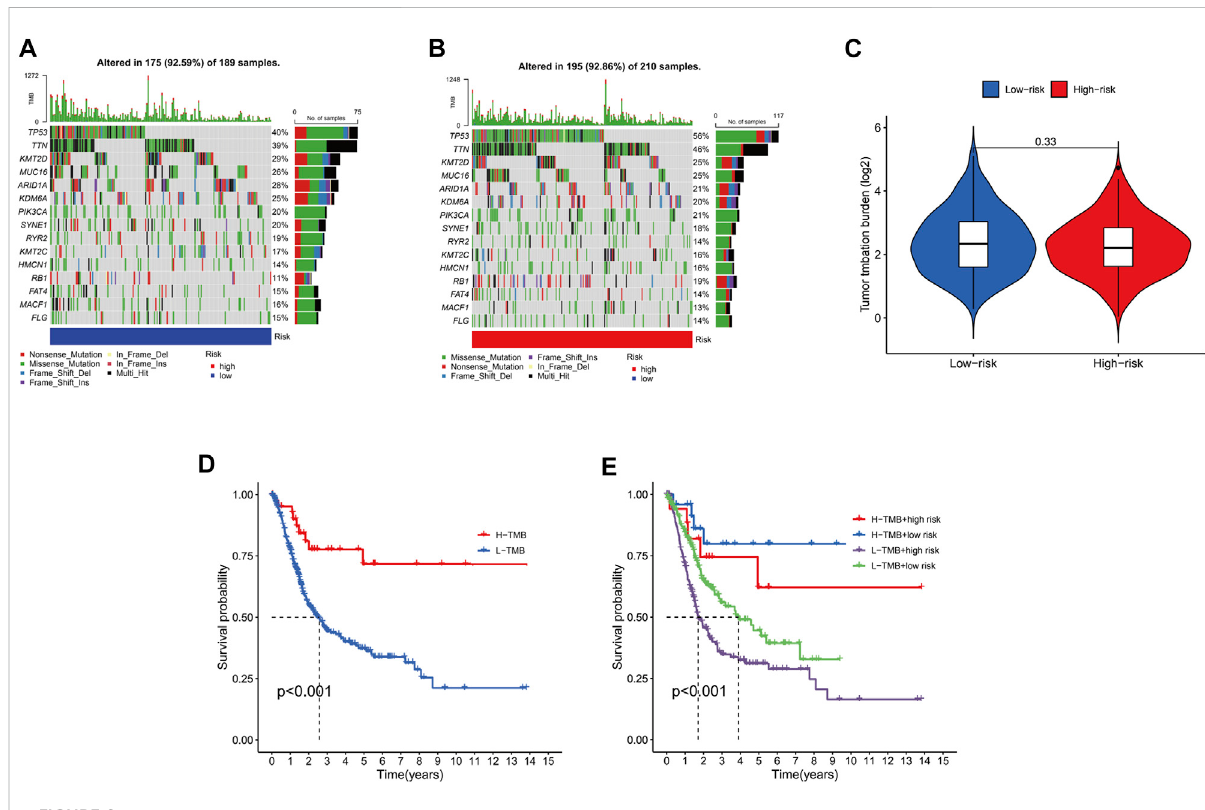
The relationship between the risk signature and TMB. Top 15 mutation genes of BC for the low-risk (A) , high-risk (B) groups in waterfall plot. (C) .DifferentTMBlevelsinsubgroupsinBC. (D) .SurvivalstatusofhighTMBlevelsandlowTMBlevelsinBC. (E) .SurvivalcurvesforcombinedTMB-risk subgroups in